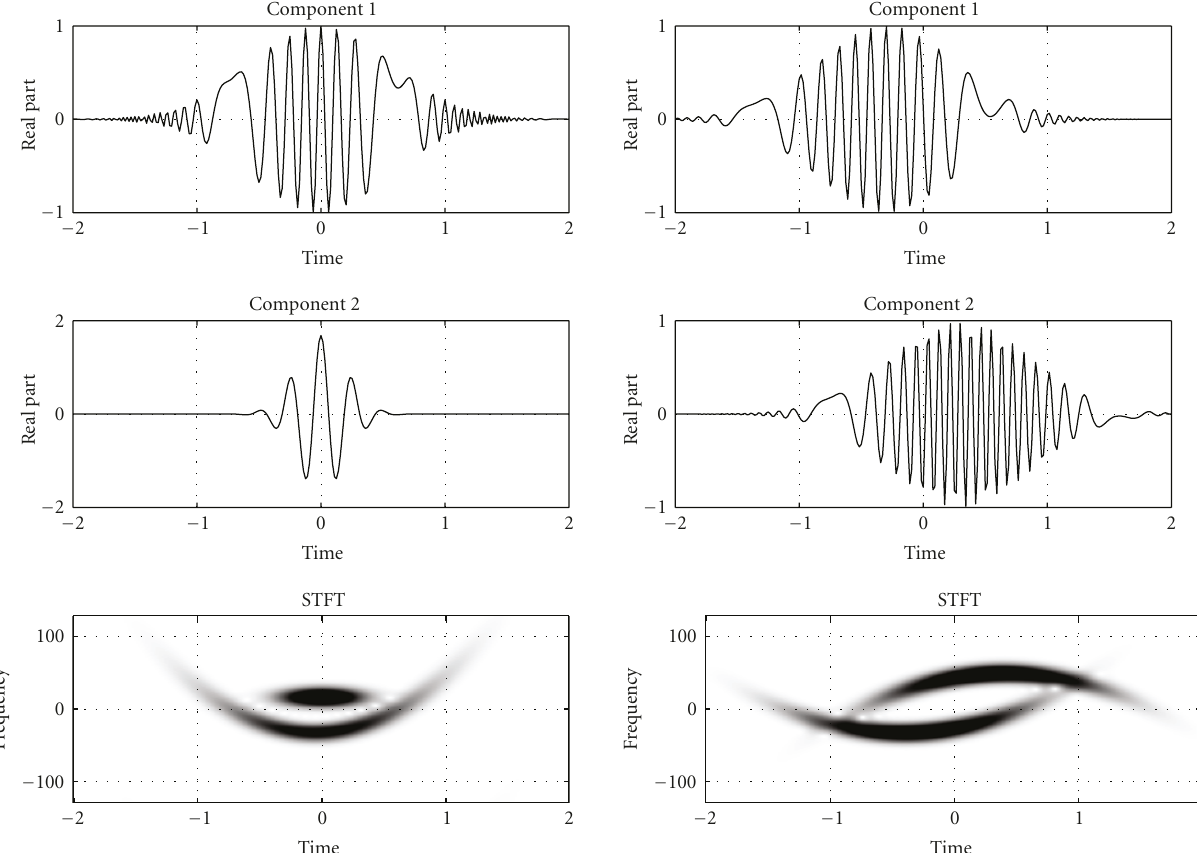
Figure 1: The Multicomponent signal examples Ex1 (left) and Ex2 with two